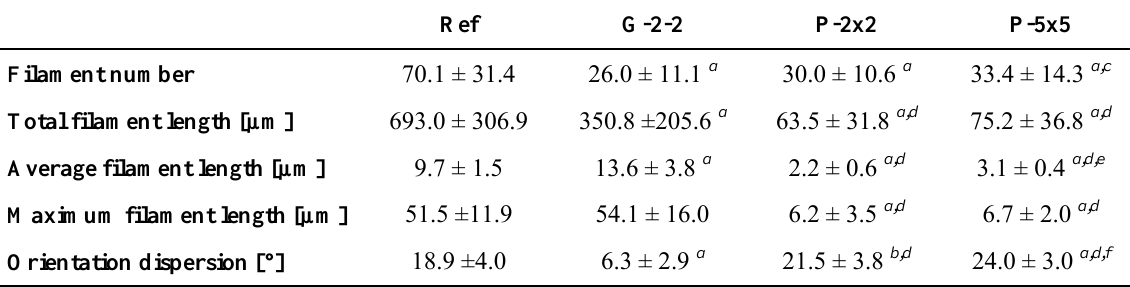
Table 1. Quantification of actin filament formation in MG-63 osteoblasts on